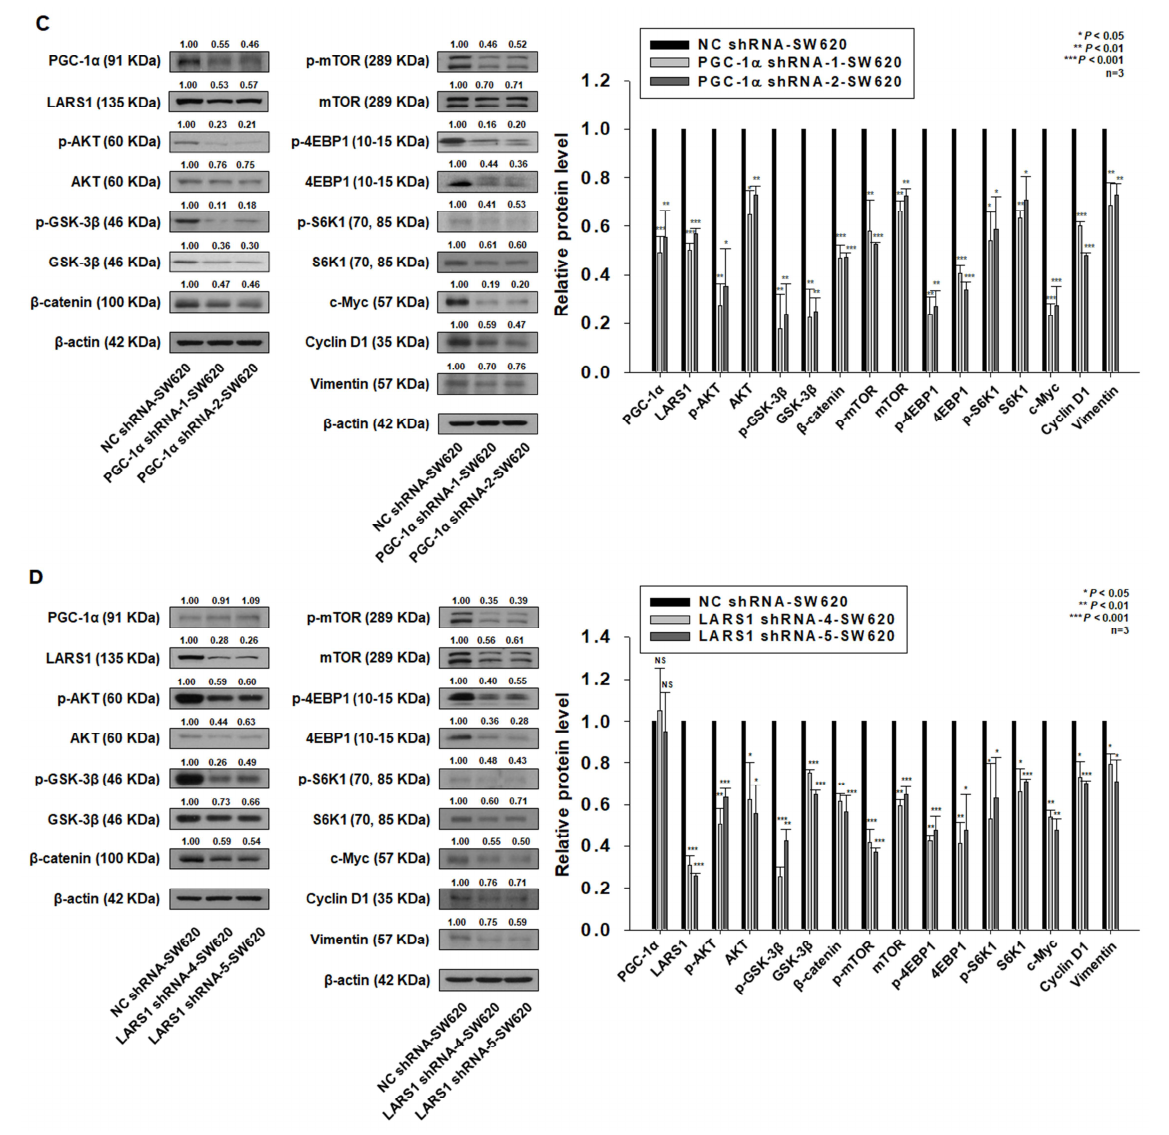
Figure 5. Expression levels of PGC-1 α , LARS1, and several signaling molecules in pcDNA-, PGC-1 α -, pCMV6-, LARS1-SW480, NC shRNA-, PGC-1 α shRNA-, LARS1 shRNA-SW620 cells. ( A ) (Left panel) Representative three independent Western blot analysis results of pcDNA-, PGC-1 α -1-, PGC-1 α -2-SW480 cells are shown. β -actin was used as a loading control. Densitometry results are expressed above bands. (Right panel) Data are expressed as the mean ± SD of three independent experiments. * p < 0.05, ** p < 0.01, *** p < 0.001 vs. pcDNA-SW480 cells. ( B ) (Left panel) Representative three independent Western blot analysis results of pCMV6-, LARS1-2-, LARS1-4-SW480 cells are shown. β -actin was used as a loading control. Densitometry results are expressed above the bands. (Right panel) Data are expressed as the mean ± SD of three independent experiments. * p < 0.05, ** p < 0.01, *** p < 0.001 vs. pCMV6-SW480 cells. ( C ) (Left panel) Representative three independent Western blot analysis results of NC shRNA-, PGC-1 α shRNA-1-, PGC-1 α shRNA-2-SW620 cells are shown. β -actin was used as a loading control. Densitometry results are expressed above bands. (Right panel) Data are expressed as the mean ± SD of three independent experiments. * p < 0.05, ** p < 0.01, *** p < 0.001 vs. NC shRNA-SW620 cells. ( D ) (Left panel) Representative three independent